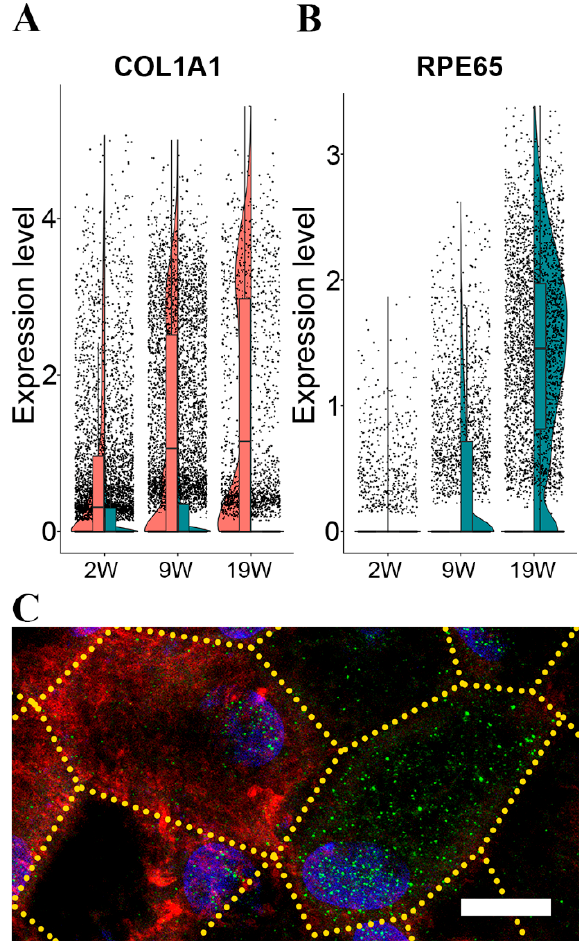
Figure 2. Gene expression pattern of more and less differentiated cell populations of in vitro RPE over time. Top markers of the more and less differentiated single-cell populations. Gene expressional change of COL1A1 ( A ) and RPE65 ( B ) over time at more (green) or less (red) differentiated cell population level; representative image of their protein expression pattern in RPE flatmounts (green: RPE65 , red: COL1A1 ) ( C ). The scale bar is 10 um. 2W-two weeks; 9W-nine weeks; 19W-19 weeks in culture.